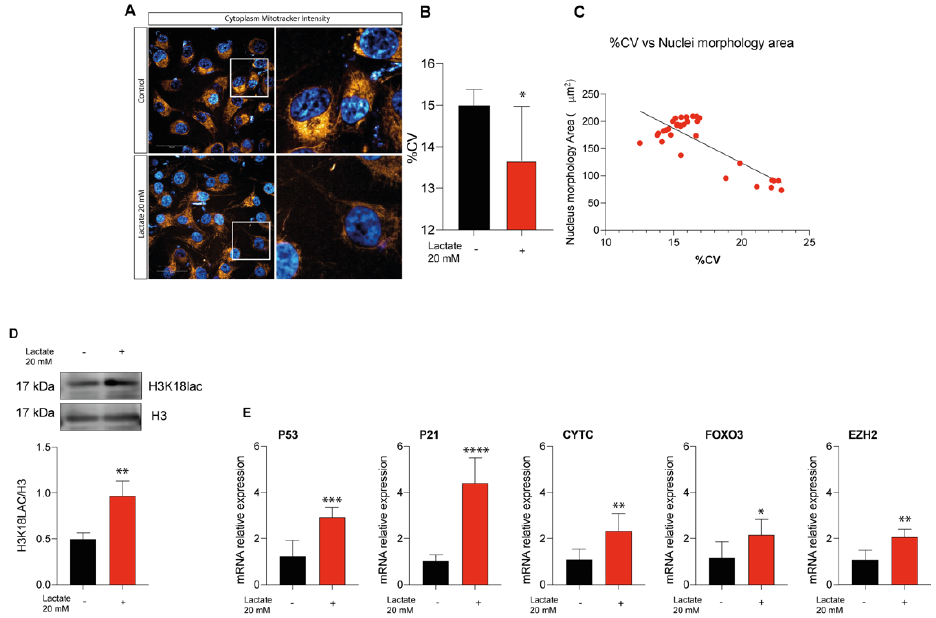
Figure 5. Lactate treatment reshaped 92.1 chromatin architecture. ( A ) Representative images showing Operetta analysis on UM cells untreated (top left) or under lactate (20 mM) treatment (bottom left). ( B ) Quantitative analysis of NucBlue coefficient of variance (CV) following lactate (20 mM) treatment. ( C ) Correlative analysis relating NucBlue %CV and Nuclear morphology area. ( D ) H3K18lac protein expression level following 24 h of lactate (20 mM) treatment. ( E ) mRNA expression levels of cellular senescence markers ( P53, P21, CYTC, FOXO3, and EZH2 ) following 24 h of lactate (20 mM) treatment. Values represent the mean ± SD of experiments performed in quadruplicate. Data are representative of four independent experiments, and graphs are mean ± SD of experiments performed in quadruplicate (Mann–Whitney U test). * p < 0.05; ** p < 0.01; *** p < 0.001; **** p < 0.0001.